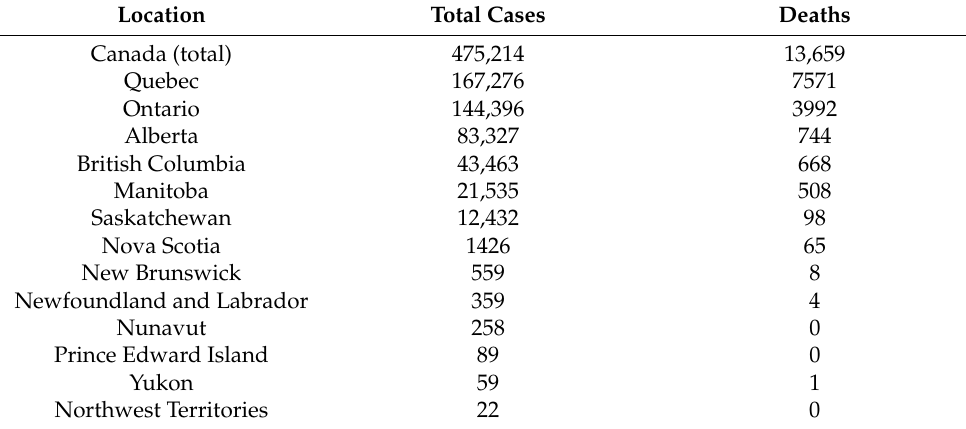
The cumulative cases and deaths in Canada (nationwide), Quebec, Ontario, Alberta, and British Columbia are shown in Figure 1. The curve of the cumulative number of deaths grows after the cumulative number of cases grows, although there was a more rapid increase in the number of deaths in Quebec. Furthermore, the associated mortality burden appears to be much higher in Quebec than in other provinces; specifically, among the 13,659 COVID-19-associated deaths in Canada, 55.4% were in Quebec and 29.2% were in Ontario, while 5.4% and 4.9% were in Alberta and British Columbia, respectively (Table 1). Notably, the fatality risk increased dramatically with age, with the crude CFR among individuals aged 80 and above reaching 25.71% (Table 2).